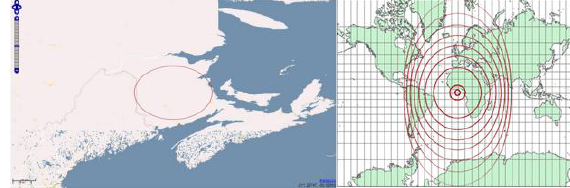
Figure 8. Examples scale contours in the map section of the visualizer.